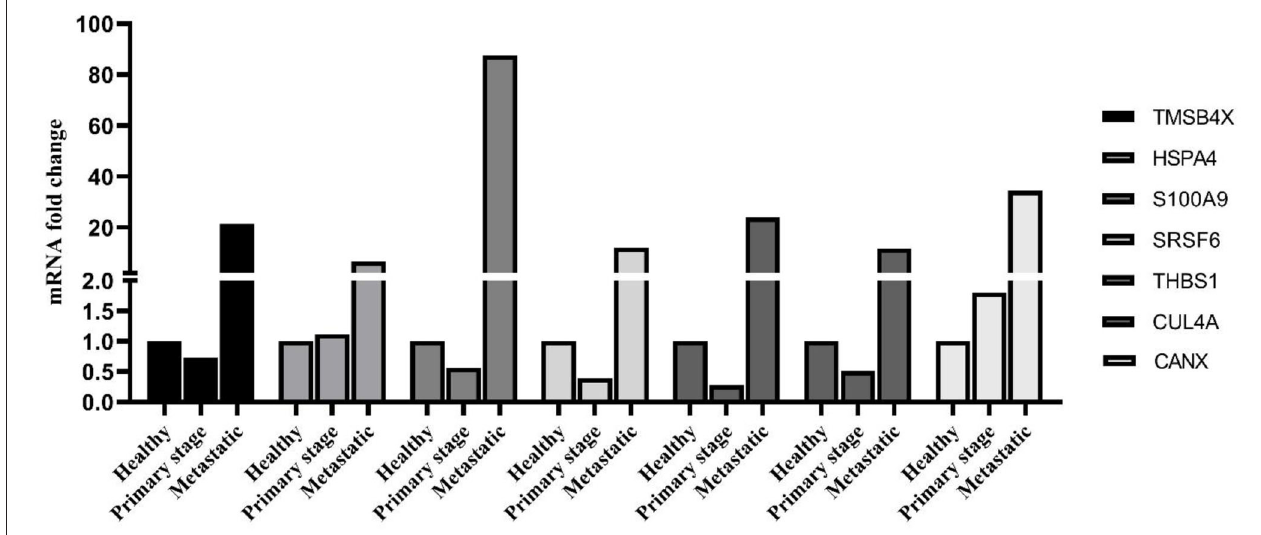
FIGURE 5 | mRNA expression level of PBMC signature genes between different groups. The linear model was used to determine statistical significance at the level of p < 0.05.